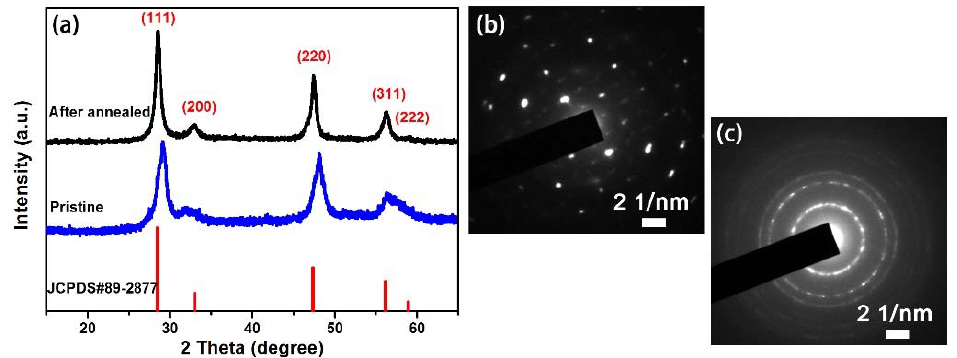
Figure 1. ( a ) XRD patterns of the pristine and annealed CTS. SAED patterns of the ( b ) annealed and ( c ) pristine CTS.